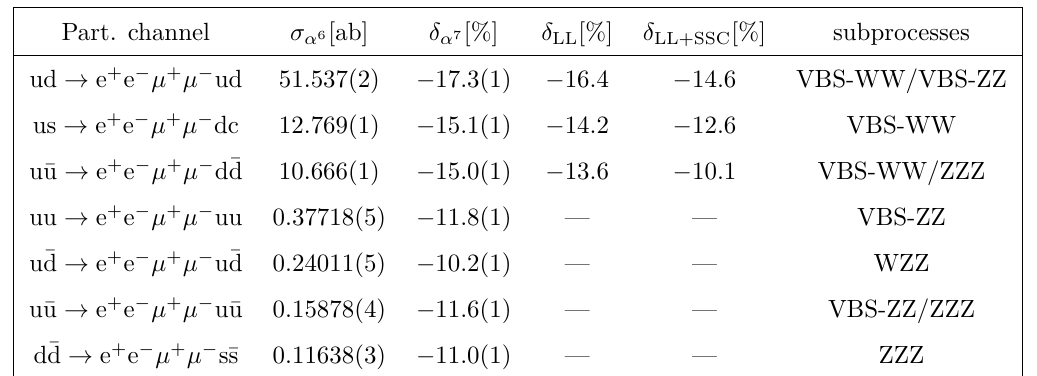
— ZZZ = ∆ σ /σ for various partonic channels and cor- α 7 α 7 α 6